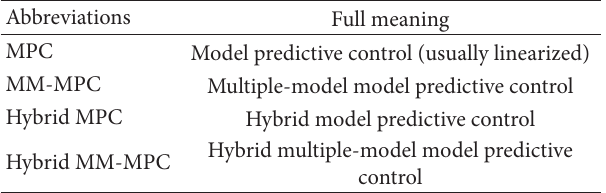
Table 1: Abbreviations and full meaning of the algorithm’s